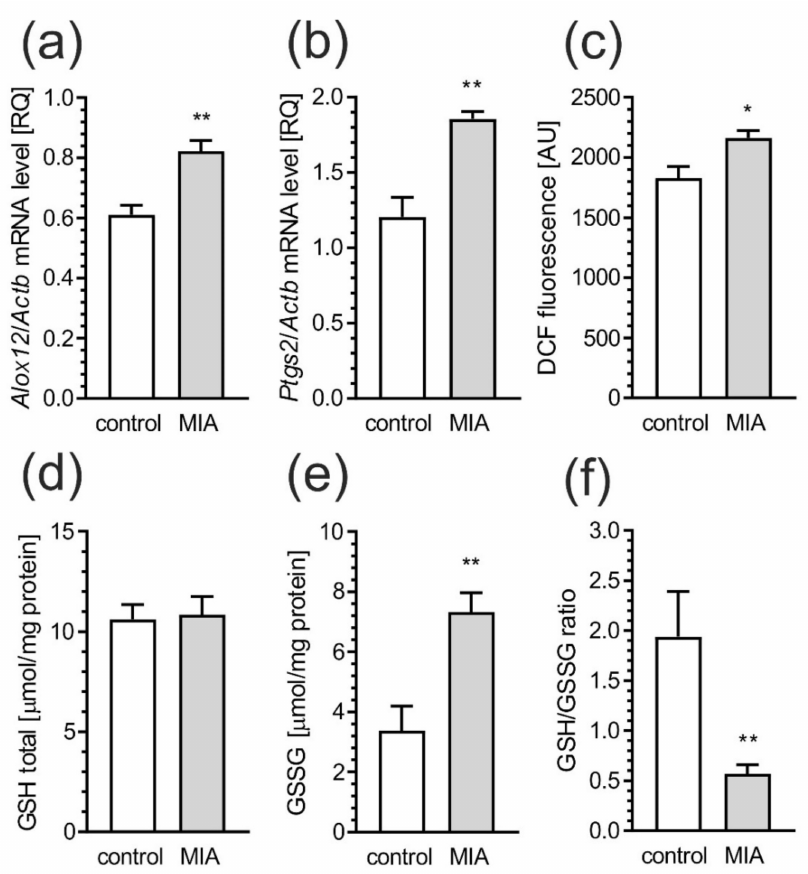
Figure 8. MIA induces oxidative stress in the brain of o ff spring rat. The e ff ects of MIA on activation of oxidative stress were analyzed in cerebral cortex of PND 52–54 male o ff spring rats. The expression of pro-oxidative genes, such as Alox12 ( a ) and Ptgs2 ( b ) were measured by real-time PCR and normalized to Actb ( β -actin), as a reference gene. The level of reactive oxygen species in tissue homogenate was determined with DCFH-DA probe ( c ). The levels of total GSH ( d ), oxidized GSSG glutathione ( e ), and ratio of GSH / GSSG ( f ) were determined by spectrophotometric assays, using Glutathione Assay Kit as described in the text. Data represent the mean value ± S.E.M. (a–n = 3, b–n = 3–4, c–n = 8, d–n =